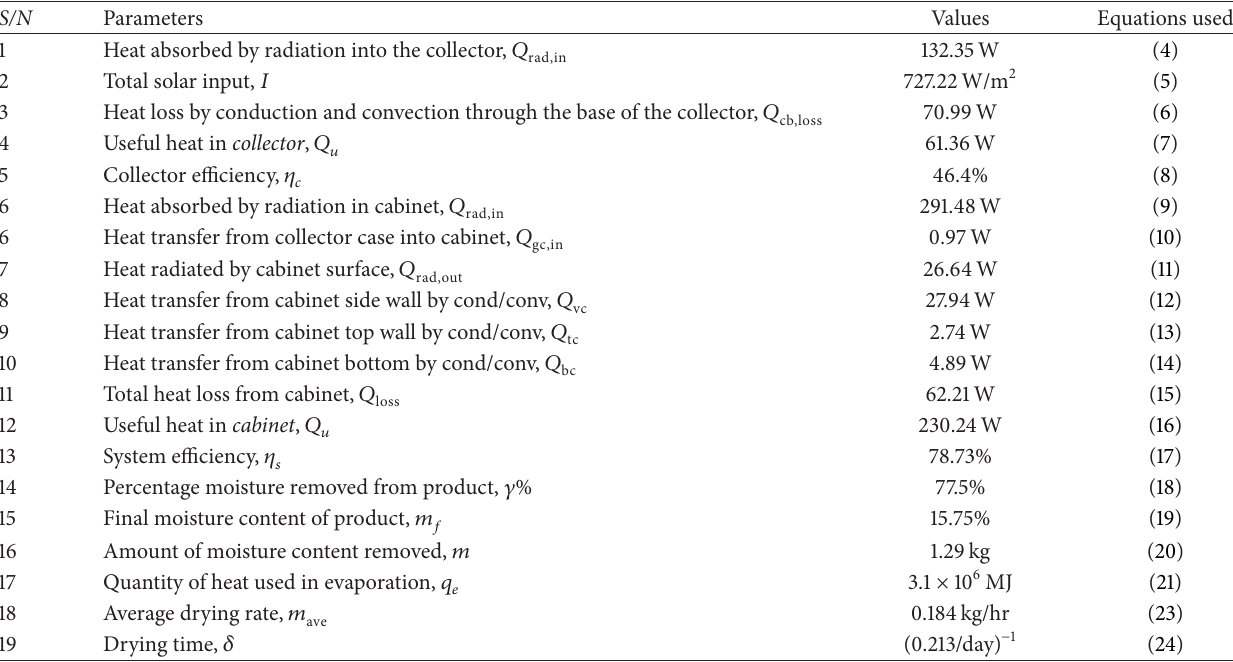
Table 2: Performance evaluation of the system.